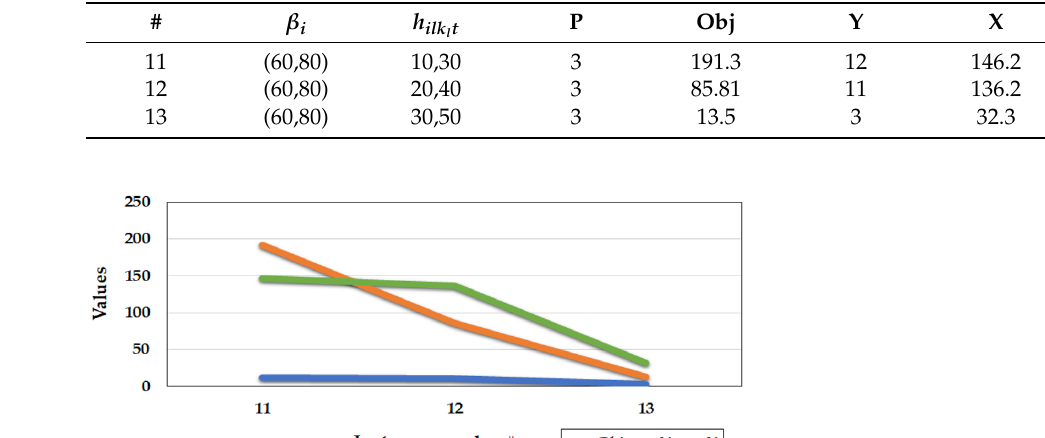
Table 4. Computational results for the effect of the increasing module assignment cost.